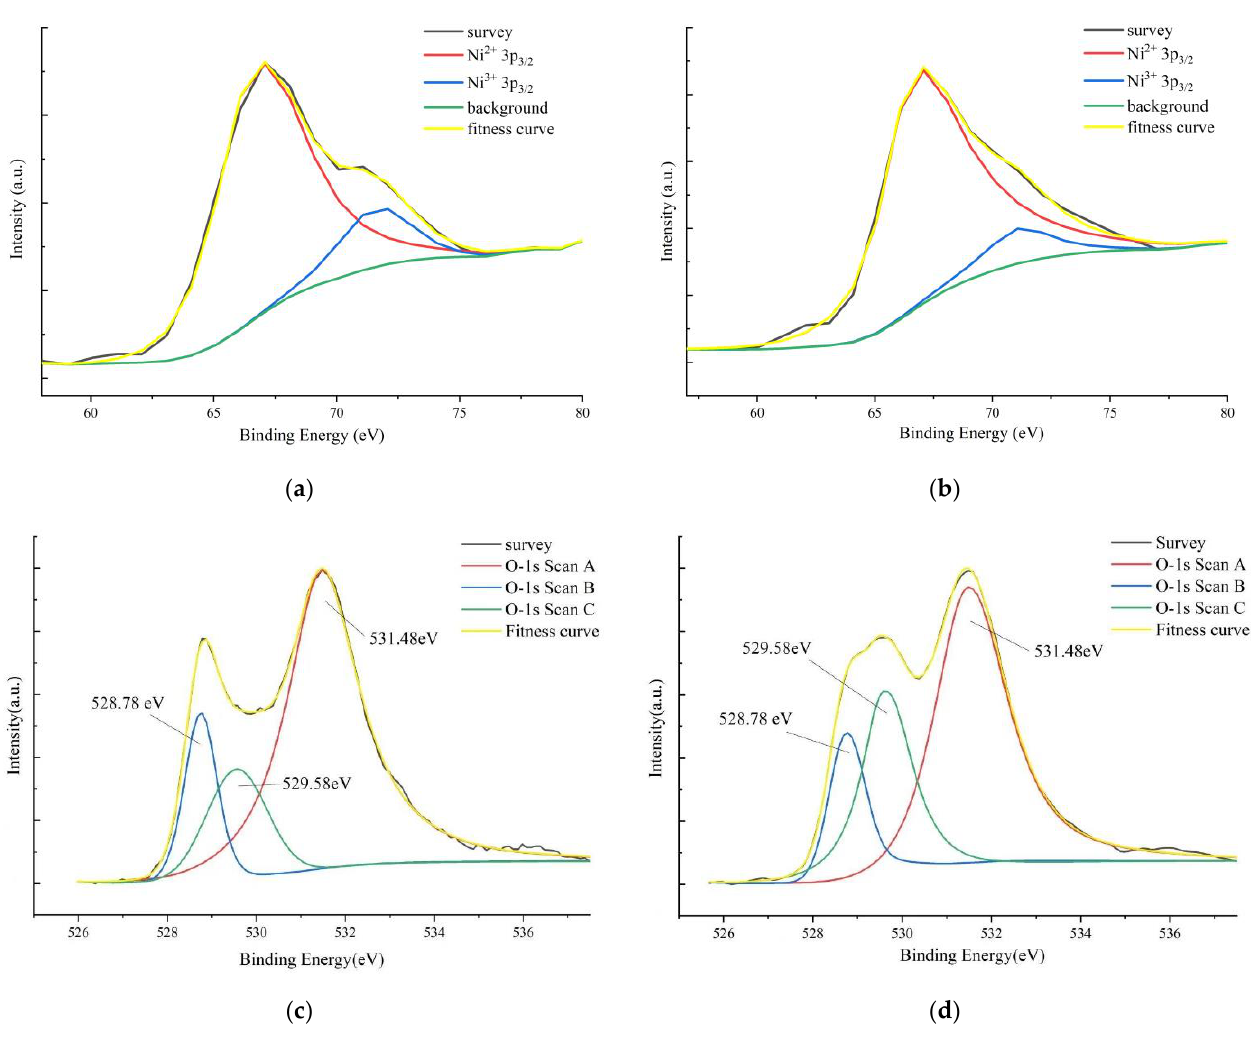
Figure 6. XPS spectrum of undoped and Sr-doped LaNiO 3−σ . ( a , b ) Ni-3p scan; ( c , d ) O-1s scan. Table 1. Calculation results of the ratio of Ni 2+ :Ni 3+ and oxygen vacancy content σ .